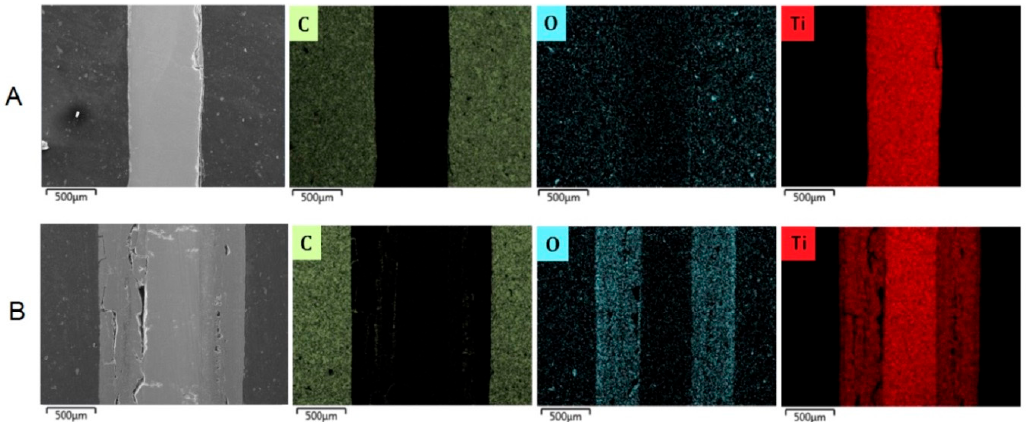
Figure 9. SEM and EDX cross-sectional analyses of coked Ti–base alloy samples after pretreatment and seven coking/decoking cycles followed by a 6 h coking. Accelerating Voltage: 15 kV. A refers to pretreatment A and B to pretreatment B.